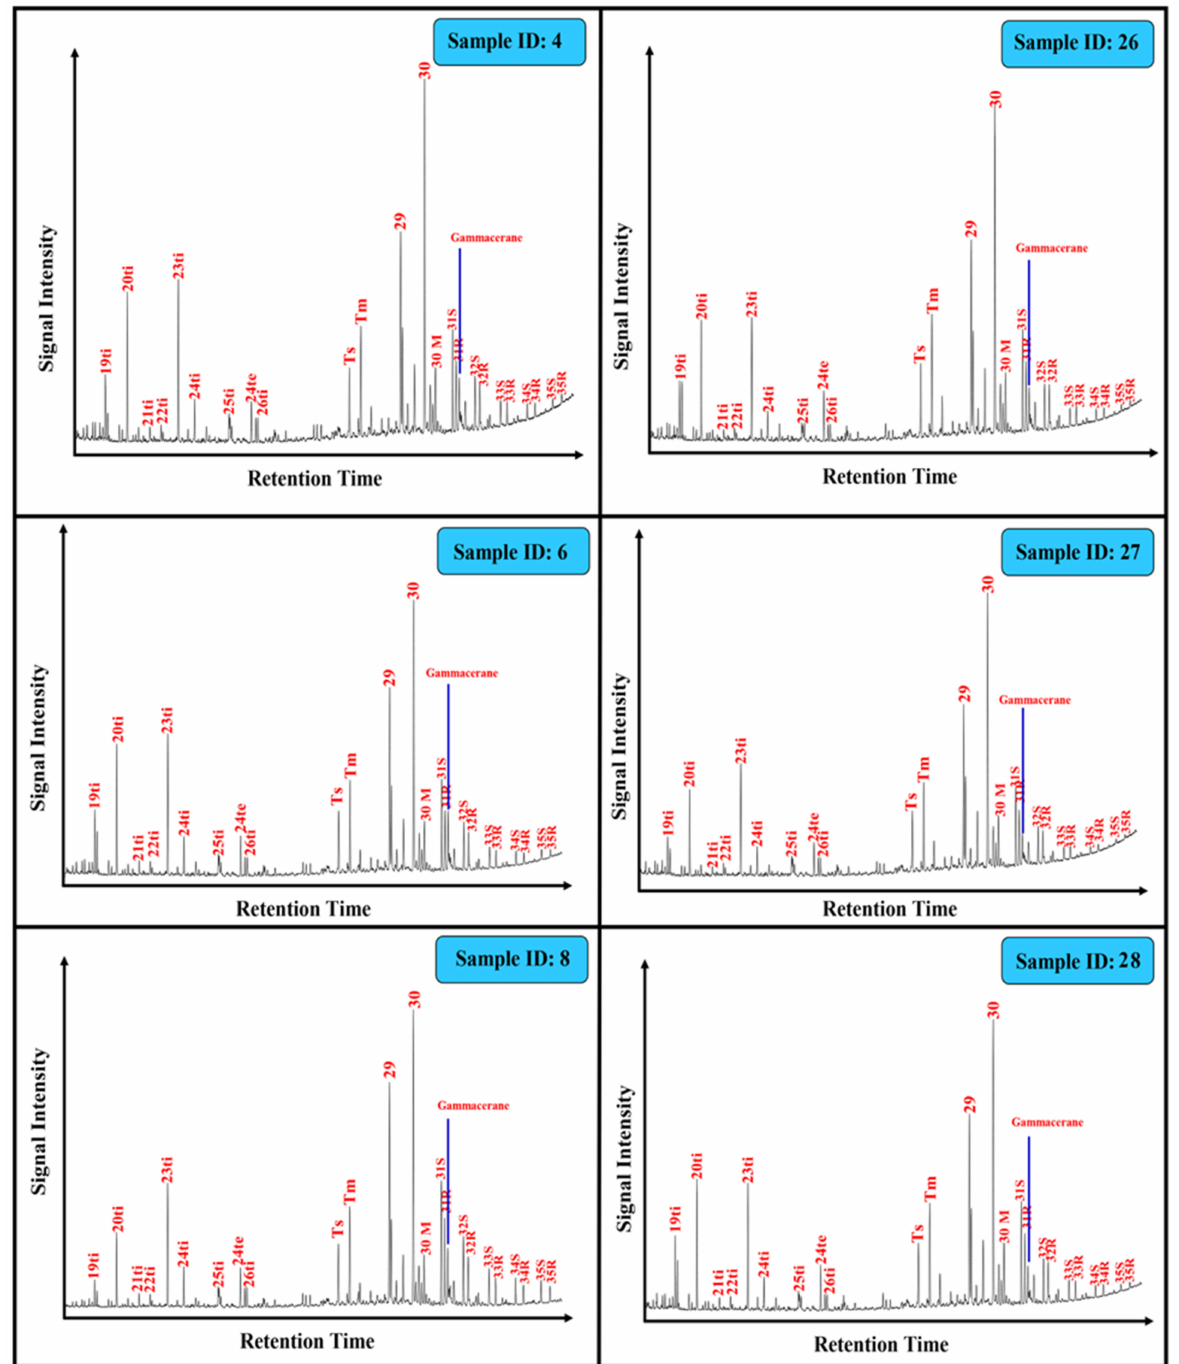
Figure 7. m/z 191 mass fragmentograms of the aliphatic hydrocarbon fraction in the analyzed shales of the Qusaiba